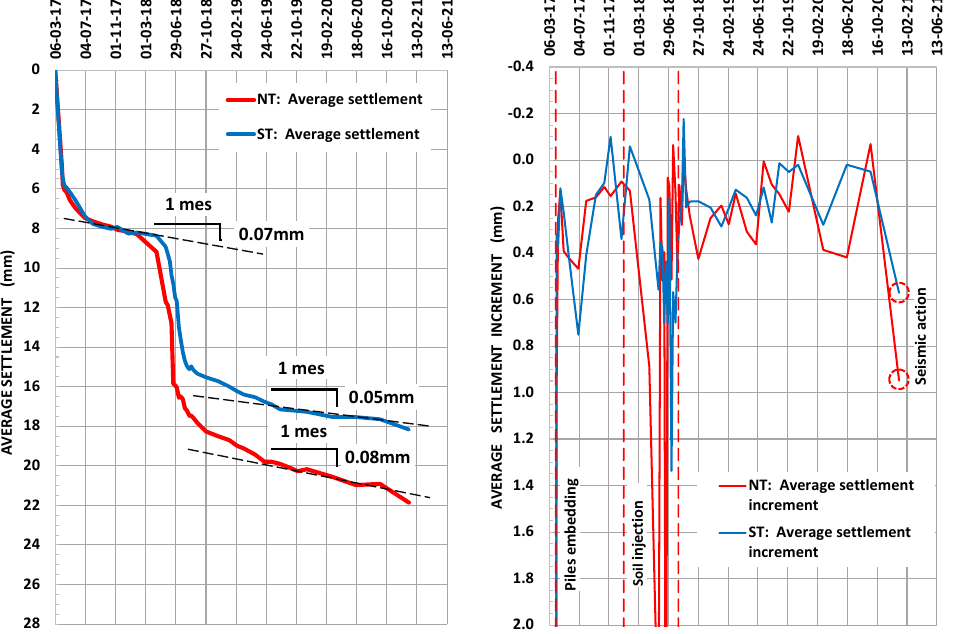
Figure 27. Diagrams of average settlement and average increment of settlement .